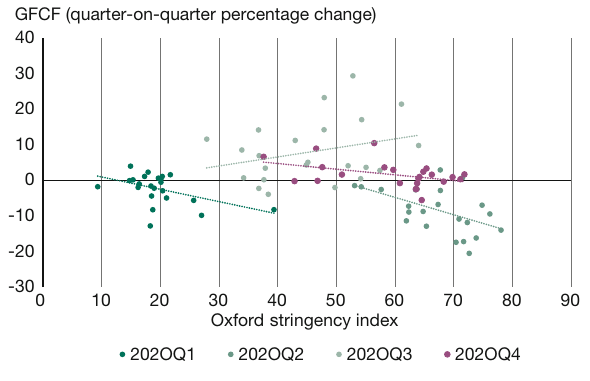
Change in gross fi xed capital formation and